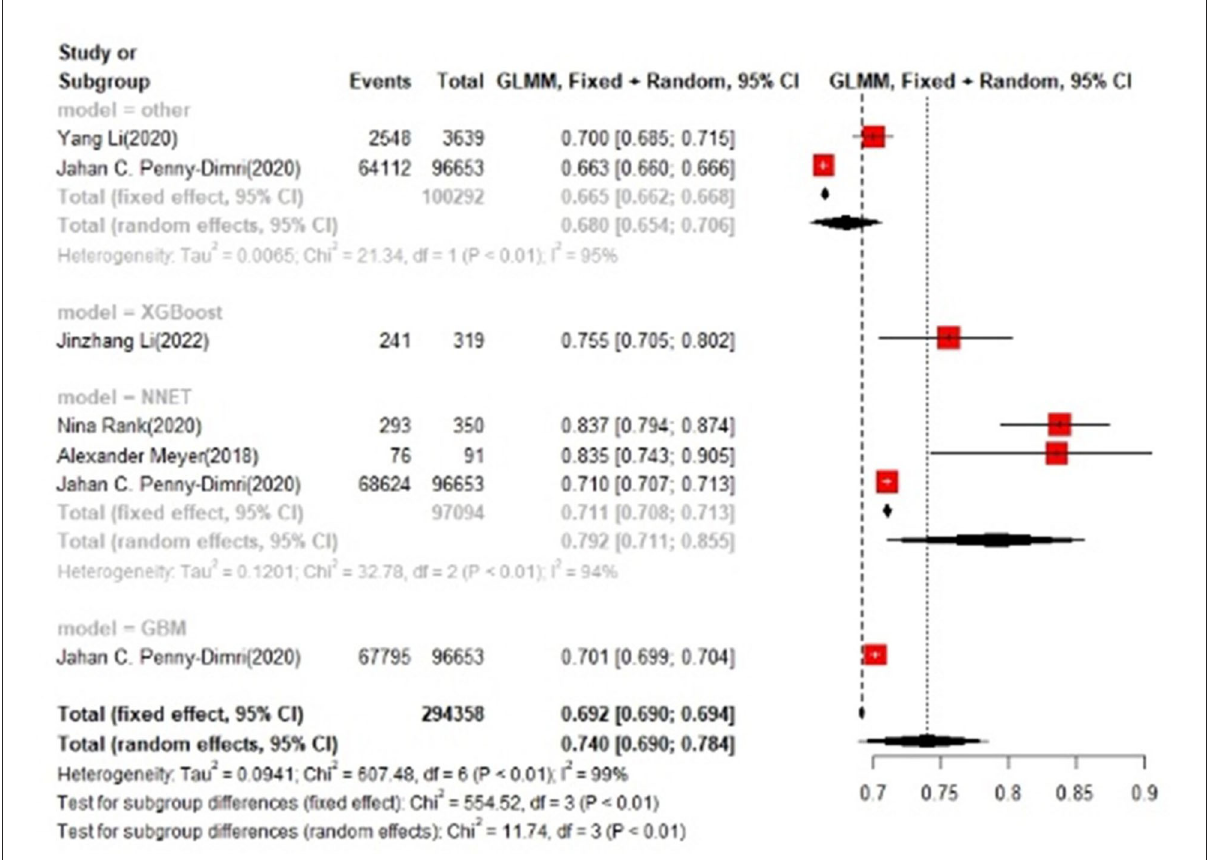
FIGURE6 Accuracy of the machine learning-based model in the test set: other